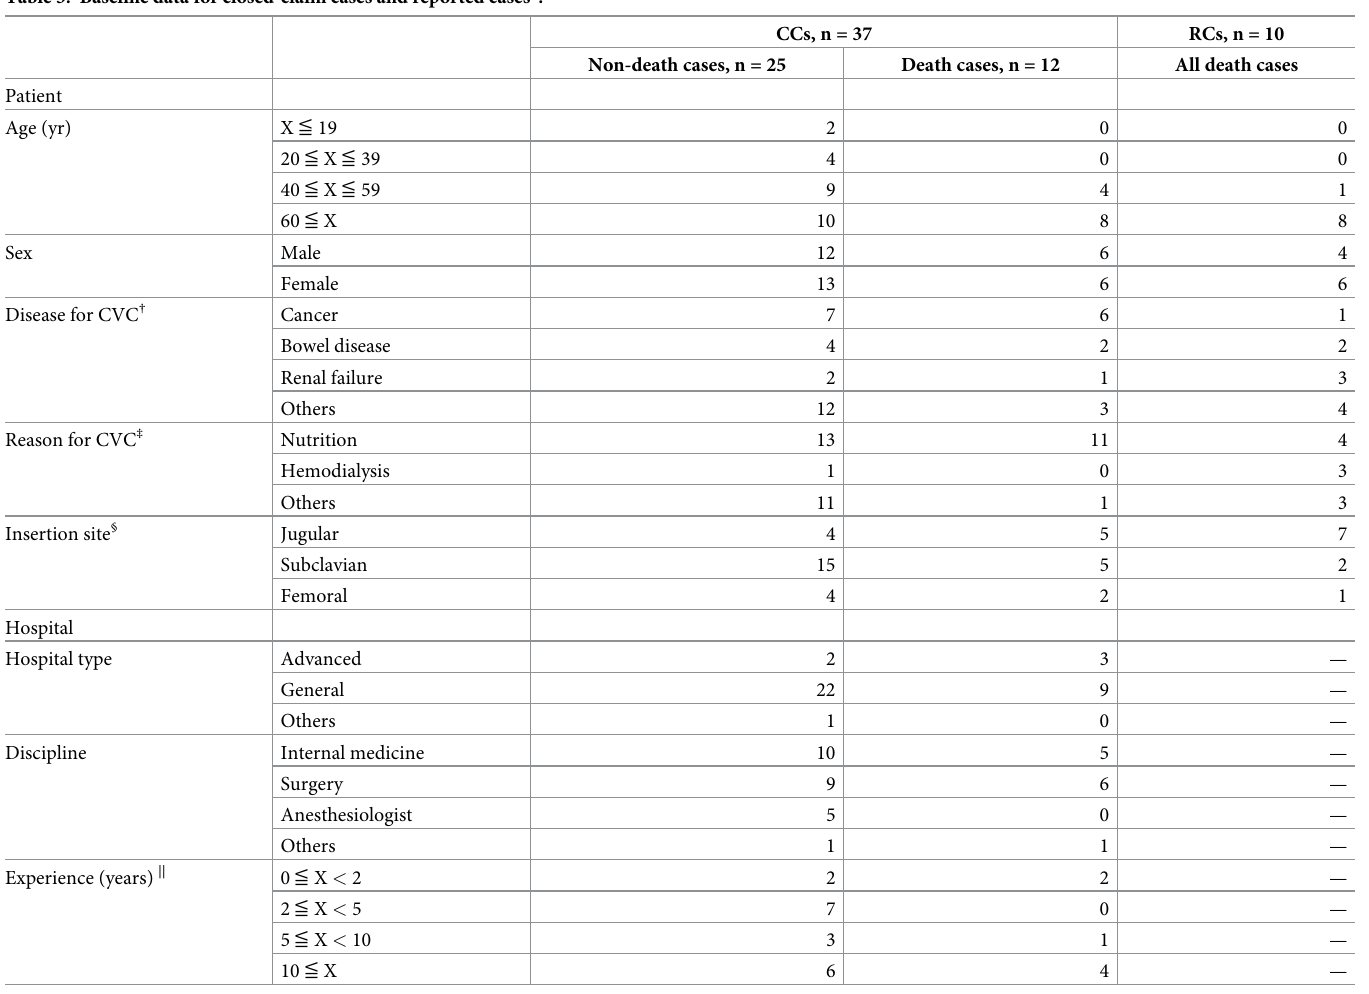
Table 3. Baseline data for closed-claim cases and reported cases �